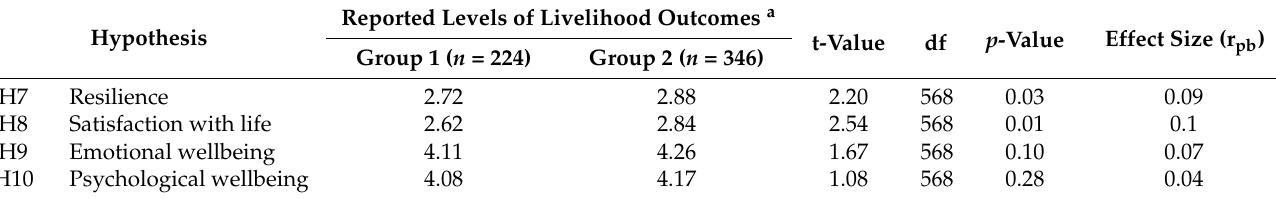
Table 5. Differences in livelihood outcomes.